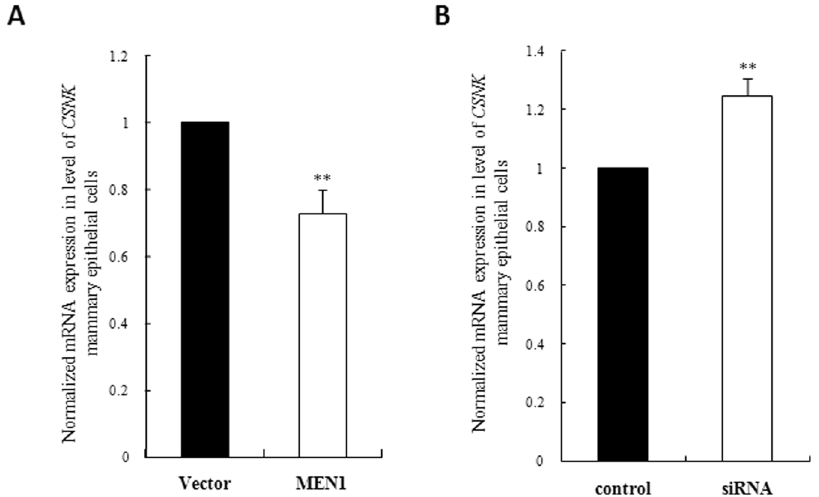
Figure 3. The RNA expression of CSNK ( κ -casein) in mammary epithelial cells was downregulated upon MEN1 /Menin overexpression and was upregulated upon MEN1 /Menin knockdown. qRT-PCR was used to analyze the effect of MEN1 /Menin on the expression of CSNK in MAC-T cells at 24 h after transfection with a MEN1 -expressing plasmid (MEN1) or a MEN1 -specific siRNA pool (siRNA) compared to their negative control cells transfected with the empty vector (Vector) or a non-specific control siRNA (control), respectively. The results, which are representative of three independent experiments, were used to determine statistical significance in both of the overexpression and knockdown system. CSNK was significantly suppressed upon transient MEN1 /Menin overexpression ( A ), but it was significantly promoted ( B ) upon transient Menin knockdown. The data are shown as the relative expression levels normalized to the internal control, β -actin. * P < 0.05, ** P <